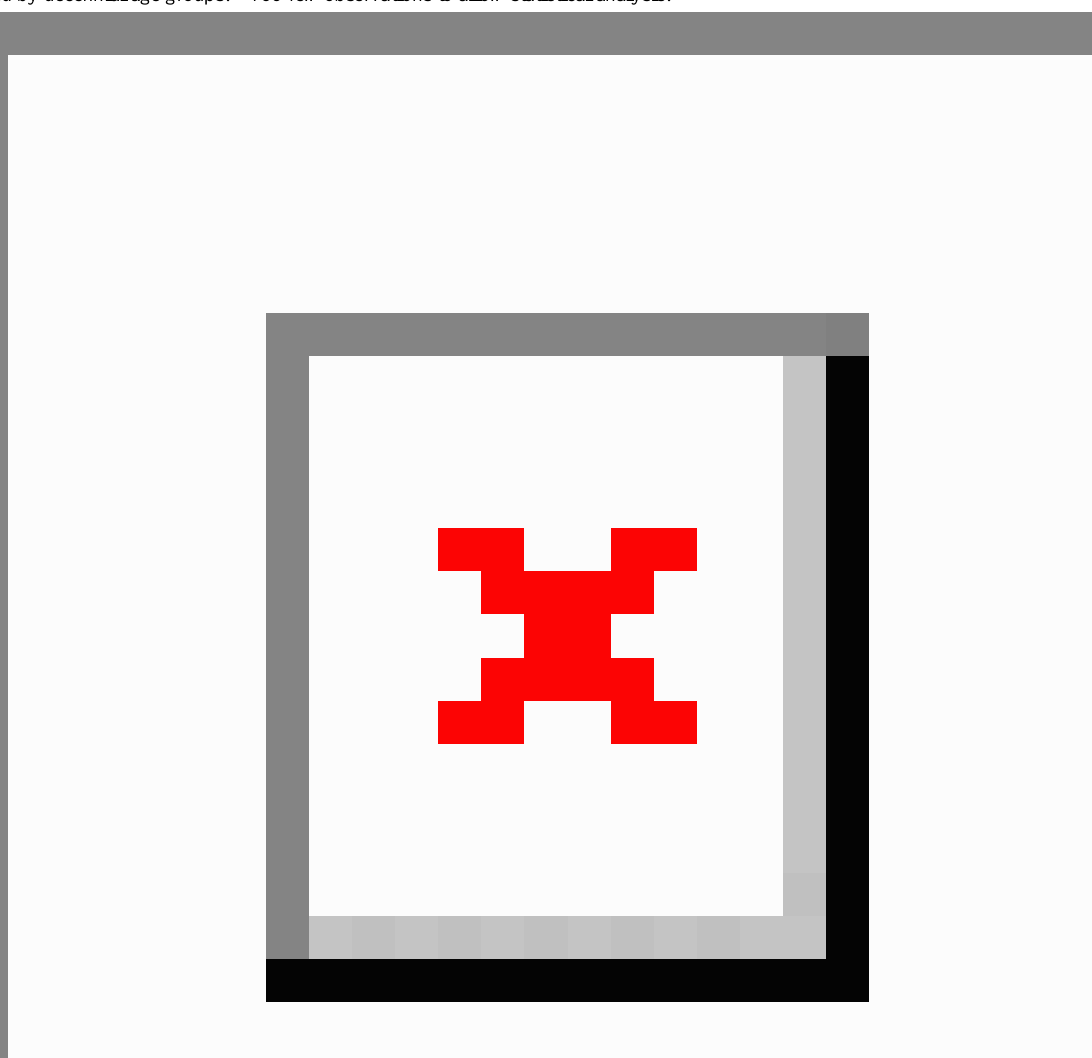
Figure 1. Relative infection ratios (RIRs) with 95% confidence intervals for influenza outbreaks between 2007 and 2012 in Östergötland county displayed by decennial age groups. ¤ Too few observations to allow statistical